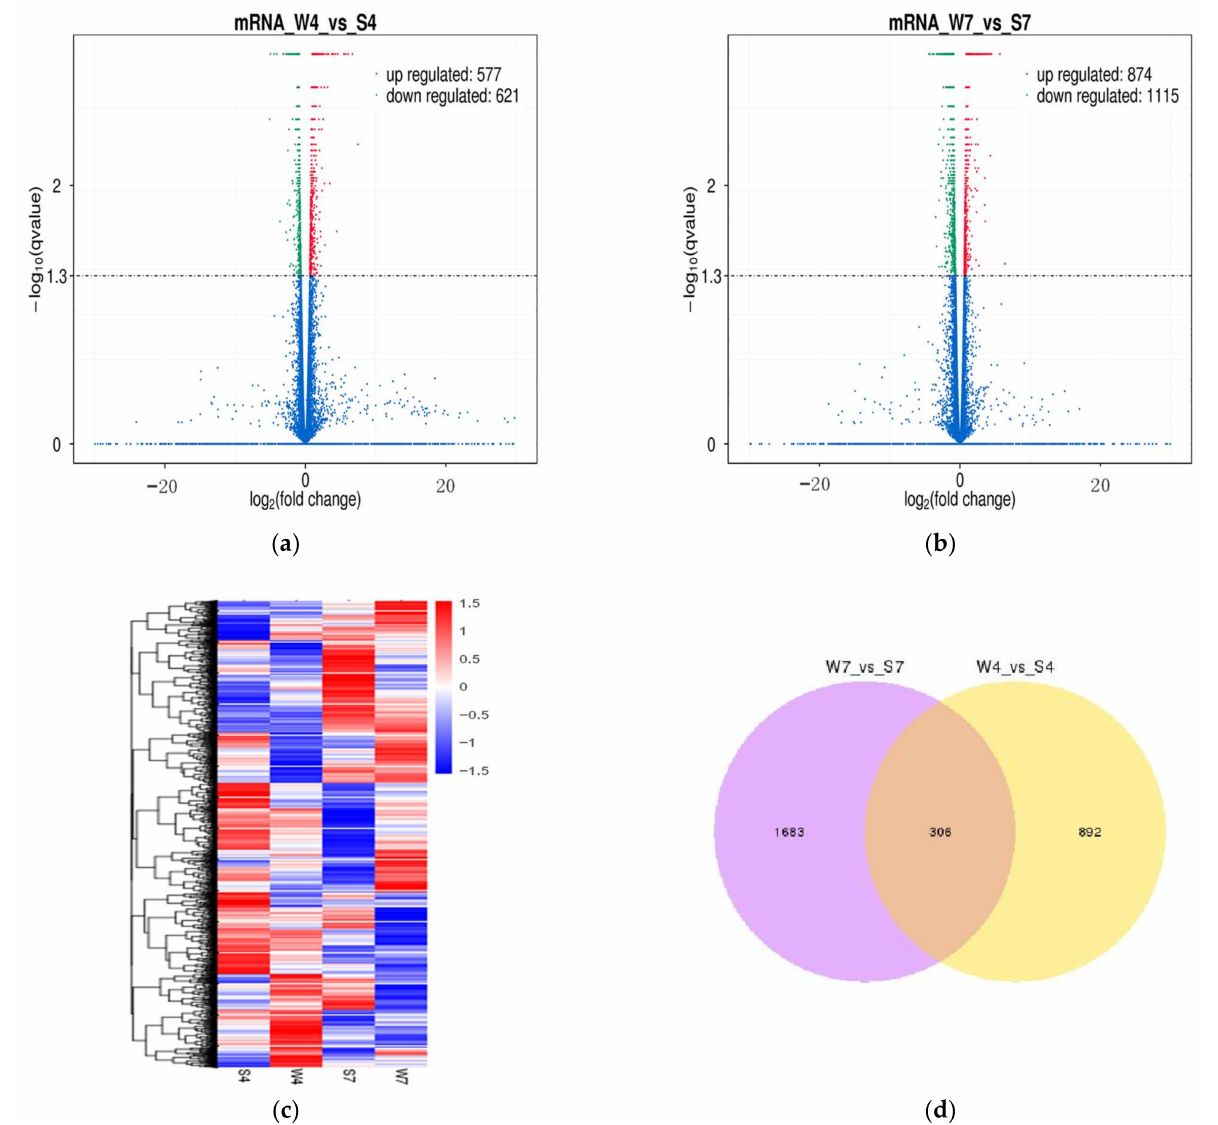
Figure 4. Differential expression analysis of intestinal mRNAs of piglet between the weaning group and sucking group. ( a ) Volcano plot of DEmRNAs in W4 vs. S4; ( b ) volcano plot of DEmRNAs in W7 vs. S7. ( a , b ) Red dots represent up-regulated genes, green dots represent down-regulated genes, and blue dots represent non-differentially expressed genes; ( c ) clustered heat map of DEmRNAs based on the FPKM values in the weaning and suckling groups. Red and blue represent high and low expression levels, respectively; ( d ) Venn diagram of common DEmRNAs in W4 vs. S4 and W7 vs.